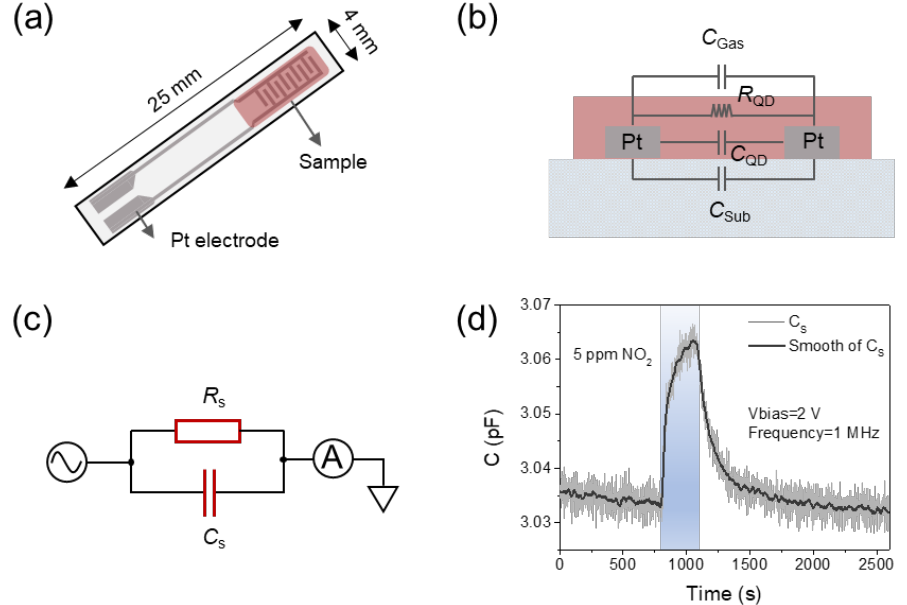
Figure 4. PbS quantum dot planar interdigitated capacitor gas sensor. ( a ) Schematic diagram of the structure; ( b ) Cross-sectional schematic diagram and impedance contributions; ( c ) Equivalent circuit model simplifying to a resistor-capacitor parallel model; ( d ) Capacitance response of PbS quantum dot gas sensor to 5 ppm NO 2 .